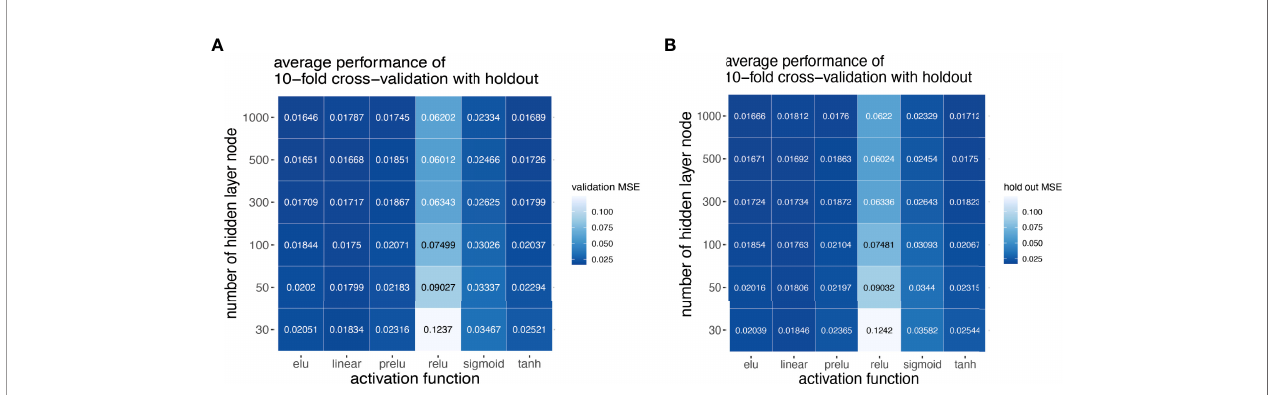
FIGURE 4 | Model selection using grid scan for combination of hyper-parameters. Different activation functions and number of hidden nodes using 10- fold cross-validation with holdout set. Hyper-parameter combinations were evaluated with validation MSE (A) , and model performance reported in holdout MSE (B) .